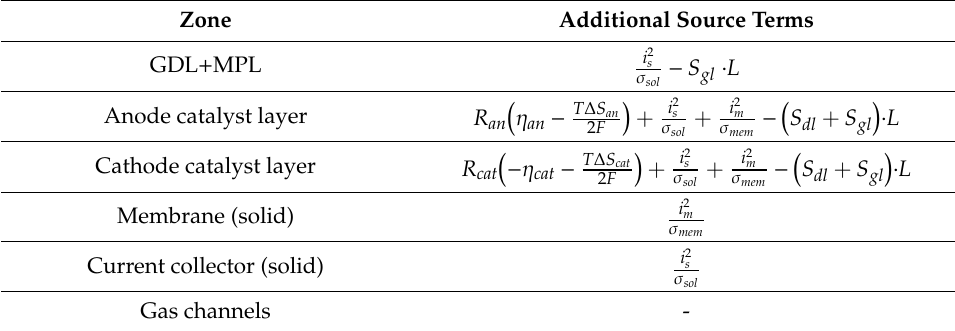
Table 3. Energy source terms for the governing equations of conservation energy